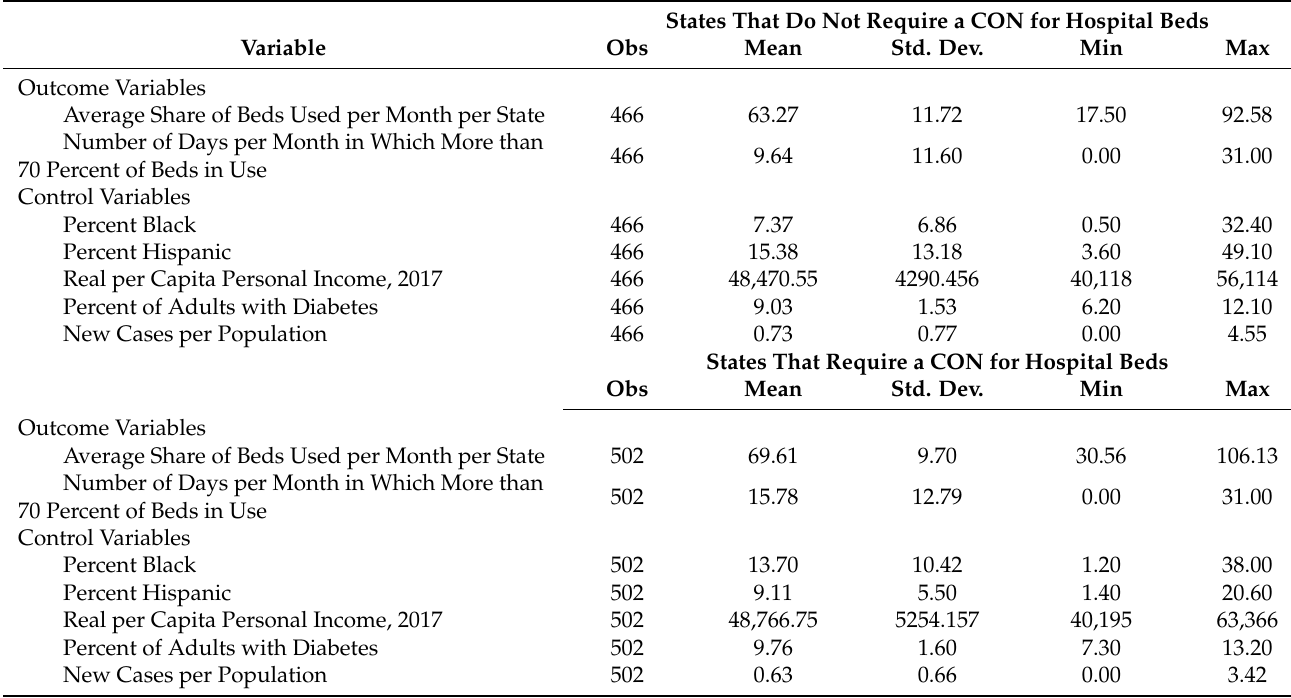
Table 2. Descriptive Statistics, Observations by State and Month, Bed CON and Non-Bed CON